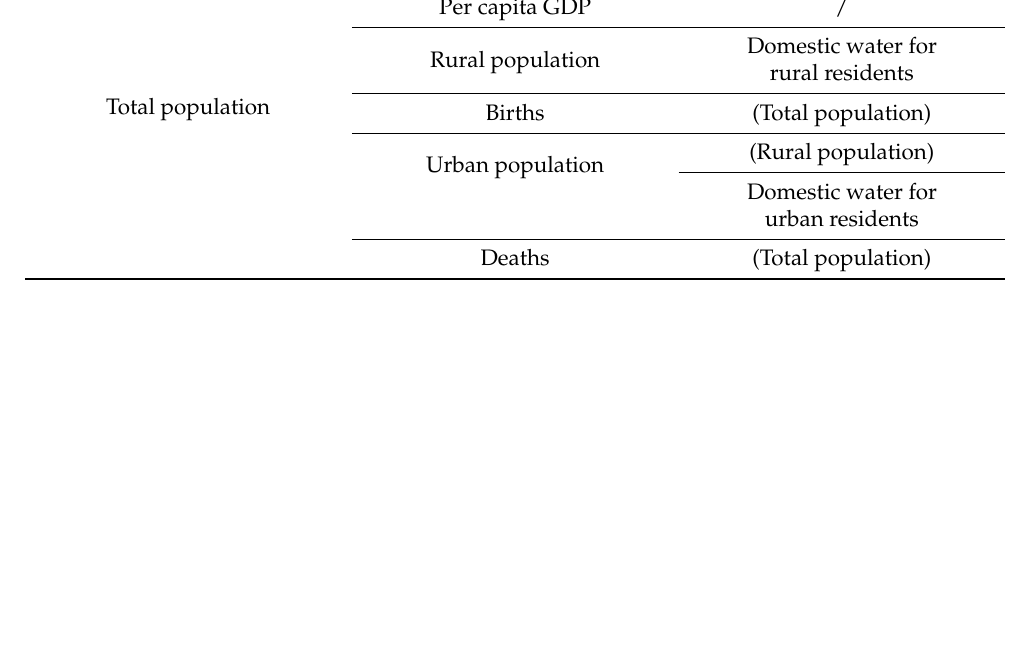
Table 3. Cause hierarchy for the water consumption.